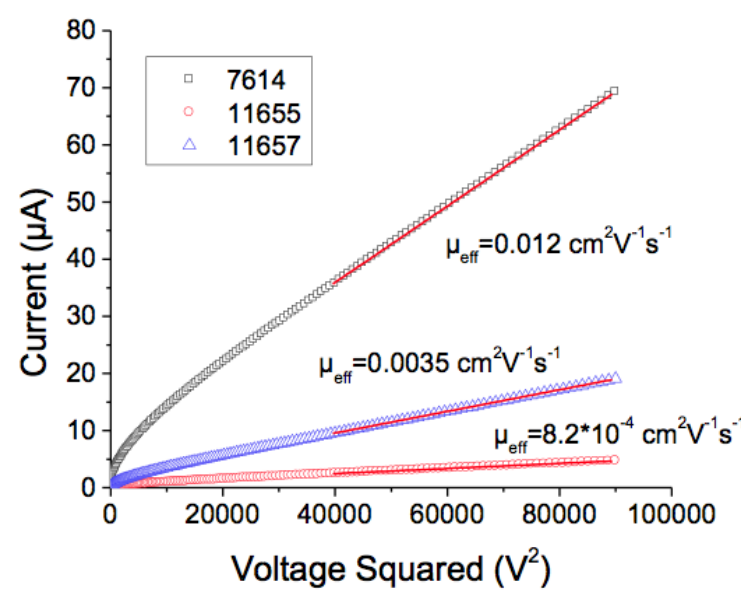
Figure 10. The current–voltage (I-V) characteristics plotted as current (I) vs. voltage squared (V 2 ) in xylindein films depending on species and strains, including C. aeruginascens strains UAMH 7614 and UAMH 11655 and C. aeruginosa strain UAMH 11657. Lines represent linear fits to Equation (2) from which effective mobilities were calculated. Calculations indicate that xylindein from C. aeruginascens strain UAMH 7614 showed the best effective electron mobility at 0.012 cm 2 /(Vs), followed by C. aeruginosa strain UAMH 11657 at 0.0035 cm 2 /(Vs) and finally C. aeruginascens strain UAMH 11655 at 8.2 × 10 −4 cm 2 /(Vs).